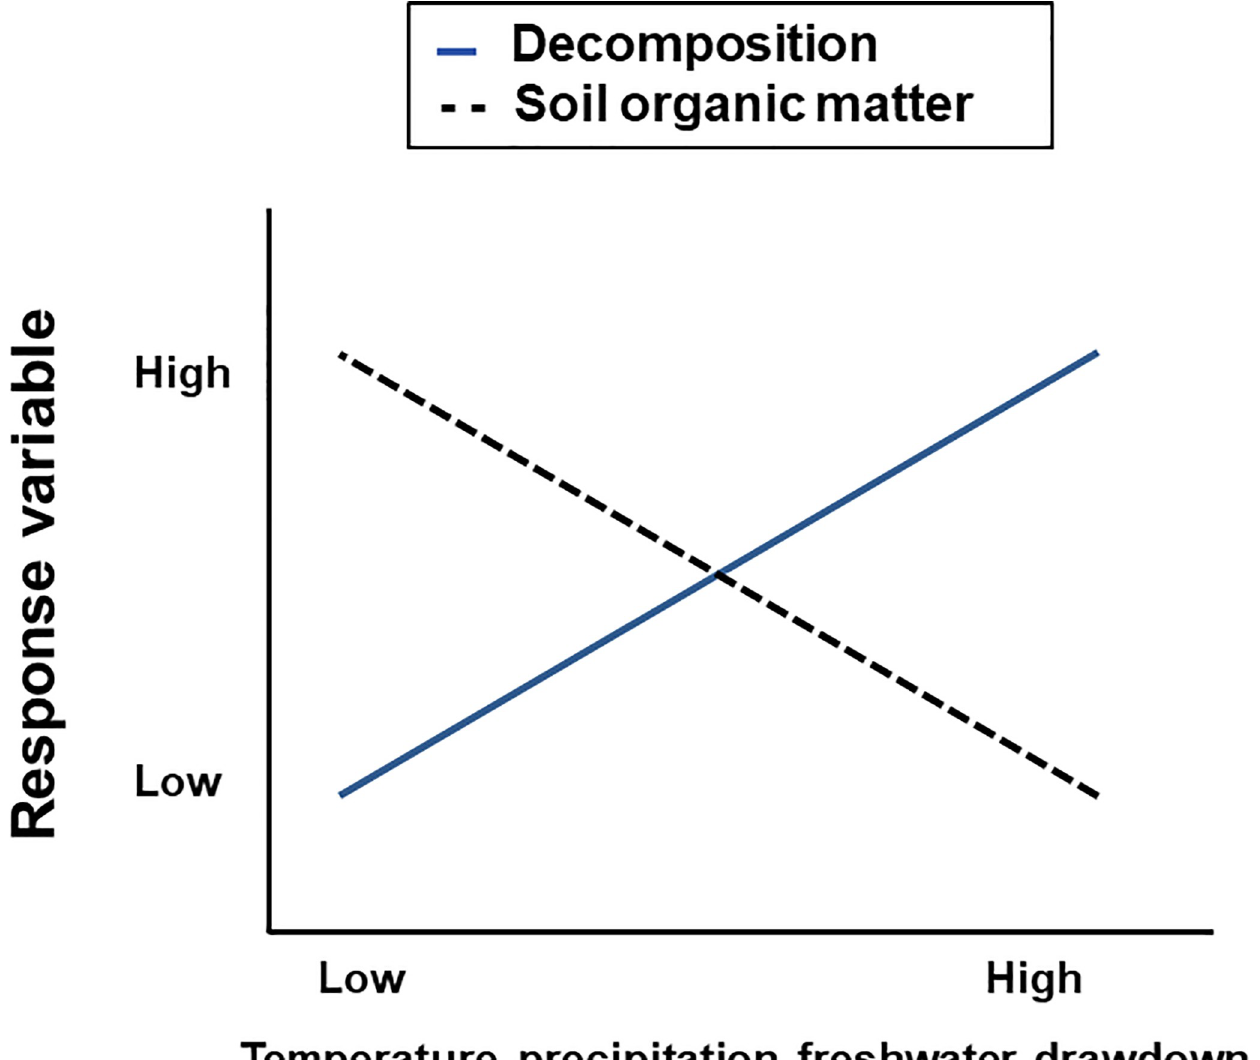
Fig 1. Hypothesized relationships of plant litter and cloth decomposition rates (solid blue line), as a logical opposite process to the accumulation of percent soil organic matter (dashed black line) across climatic and environmental gradient of temperature, precipitation, freshwater (vs. salinity) and drawdown (mathematical complement of flooding). For the purposes of this hypothesis, freshwater often is linked to higher levels of litter decomposition, and is an environment that could lower soil organic matter accumulation. While no literature could be found supporting freshwater in this role, the idea is presented here as part of the related